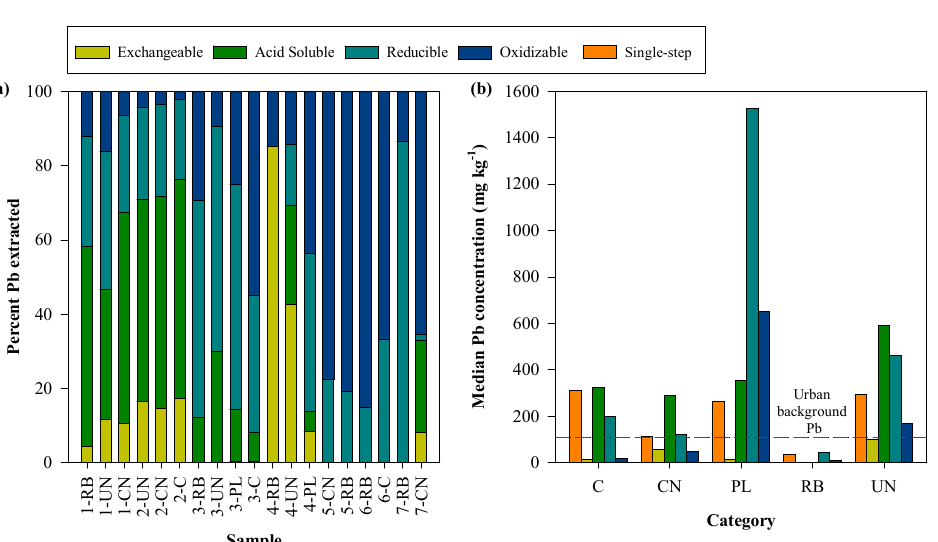
Figure 3. Tessier sequential extraction ( a ) normalized to the sum of the total Pb extracted from each fraction; ( b ) median Pb concentration for each step of the sequential extraction and the single-step extraction by sample category referenced to the urban background Pb concentration (111 mg kg − 1 ) .